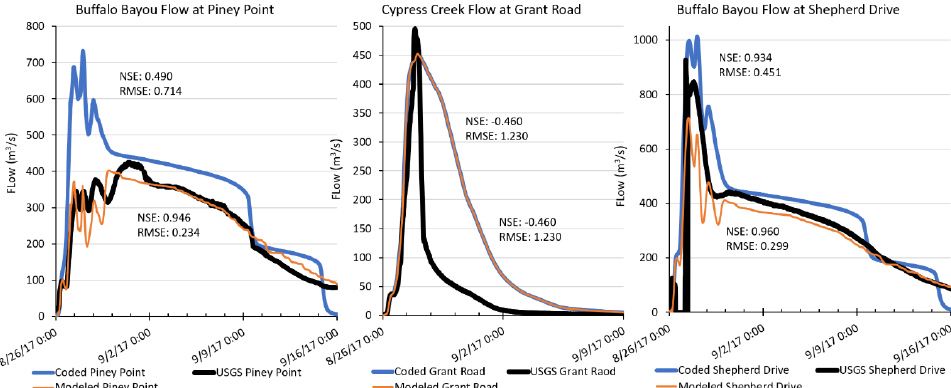
Figure 5. Channel flow comparisons during Hurricane Harvey.